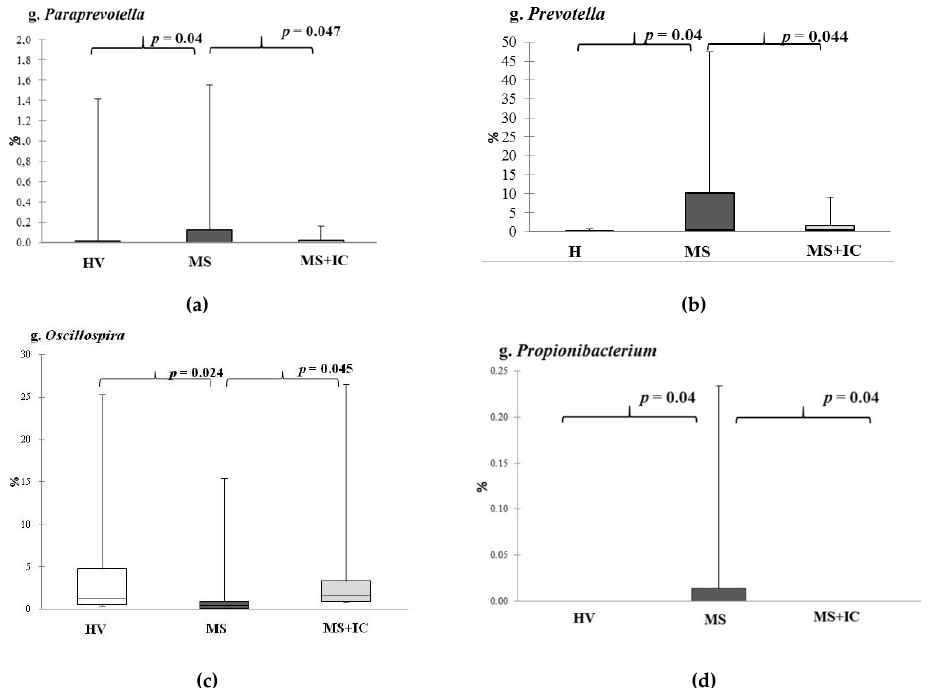
Figure 8. The relative abundance of microbiota content of patients with MS before and after IC by metagenome study (16S rRNA). Genera: Paraprevotella ( a ), Prevotella ( b ), Oscillospira ( c ) and Propion- ibacterium ( d ). Notes: HV — healthy volunteers; MS — patients with metabolic syndrome; MS + IC — patients with metabolic syndrome after consumption of indigenous consortium. Results are presented as median (25%; 75%).